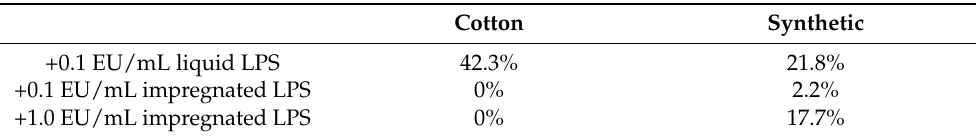
Figure 1. The MAT with human whole blood revealed inflammatory activation by cotton to a similar extend as 0.1 EU/mL liquid LPS added to blood, but there was no activation by synthetic swabs. Secretion of IL1 β by blood monocytes is presented as scatter plot with means ± SEM. **** p < 0.0001, significantly different from blood without additives. One-way ANOVA with Tukey multiple comparison post hoc test. Table 3. Proportional LPS recovery rates when added as liquid spike or when impregnated to the surface of the